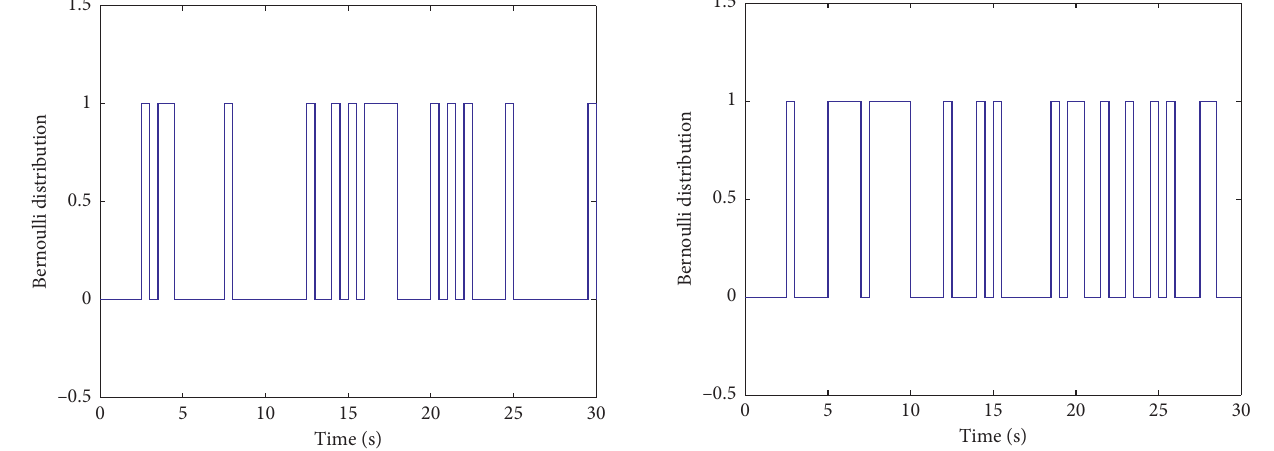
Figure 9: The jump of Bernoulli distribution in Case 3.